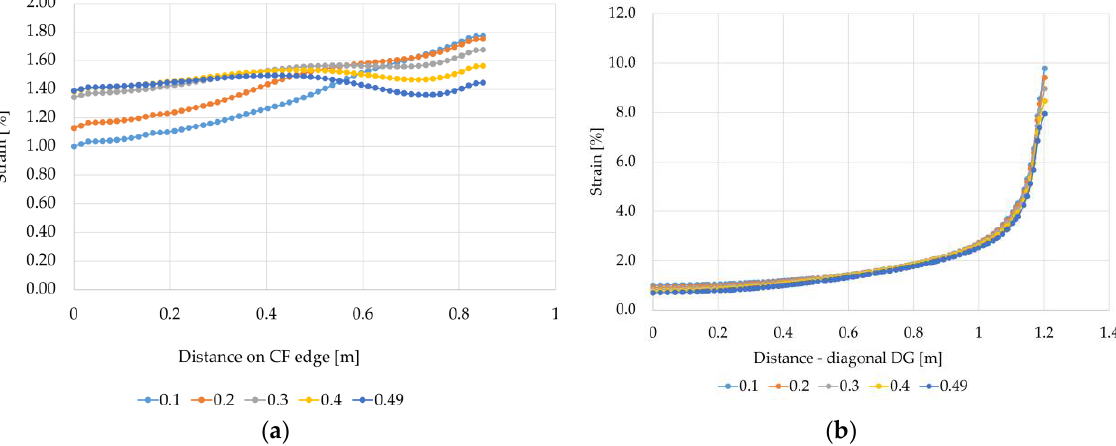
Figure 16. Graphs of membrane strains depending on the Poisson’s ratio value—variant A1: ( a ) the edge CF, ( b ) the diagonal DG.